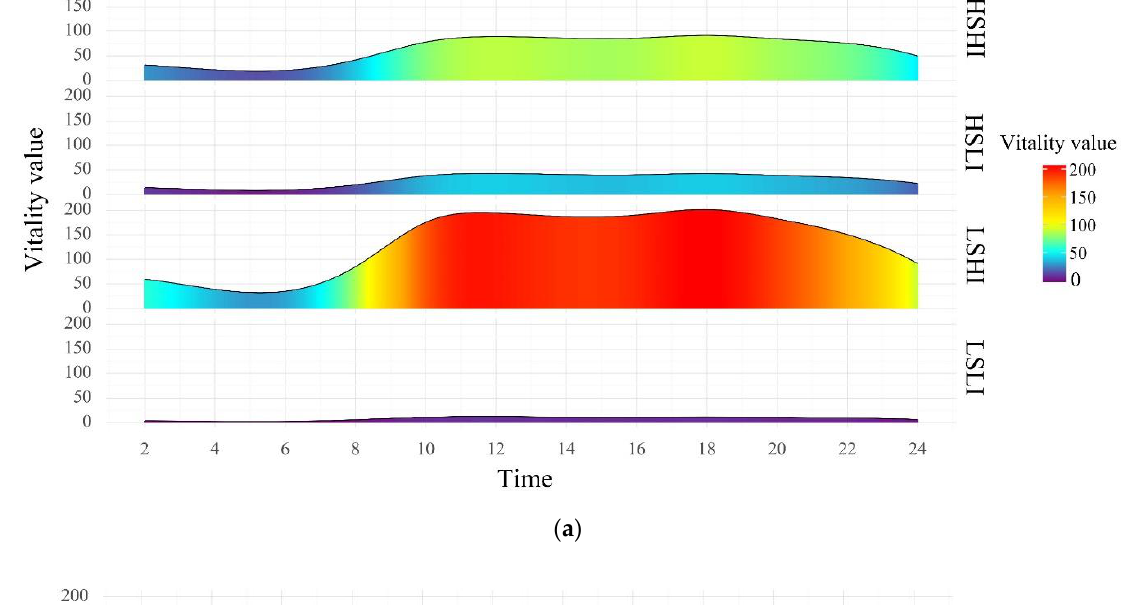
Figure 8. Spatial distribution of changes in street vitality types from weekdays to weekends.